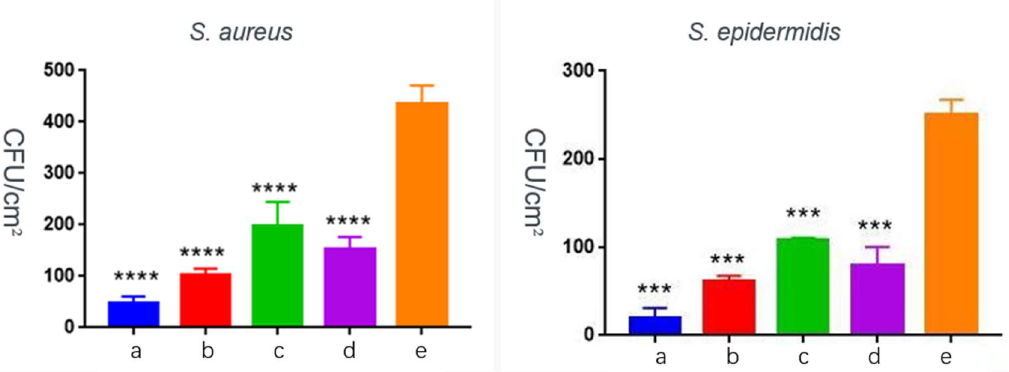
Figure 5. S. aureus and S. epidermidis growth on samples with different coatings after 6 h incubation. Data represent mean ± SD, N = 4. *** p < 0.001, **** p < 0.0001 compared with Ti control. Notes: ( a ) groove pattern; ( b ) micro-hole pattern; ( c ) directional grain pattern; ( d ) stripe pattern ( e ) control group.